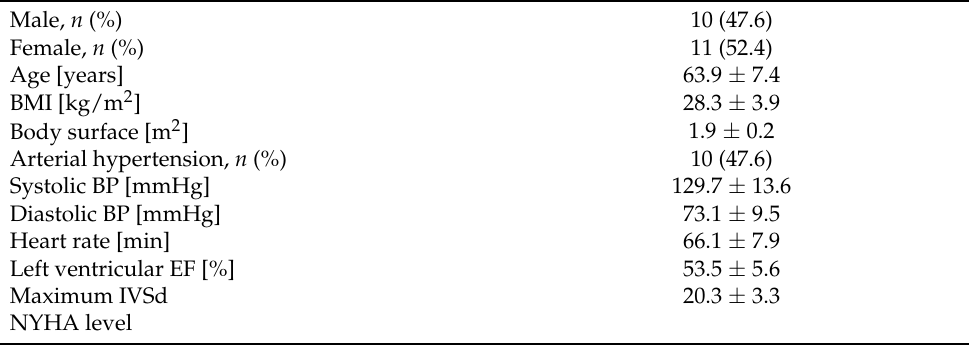
Table 2. Baseline demographics of HCM